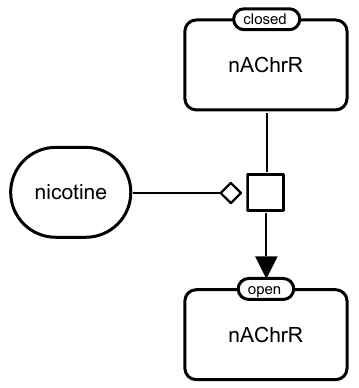
Figure 2.42: Modulation of nicotinic receptor opening by nicotine.